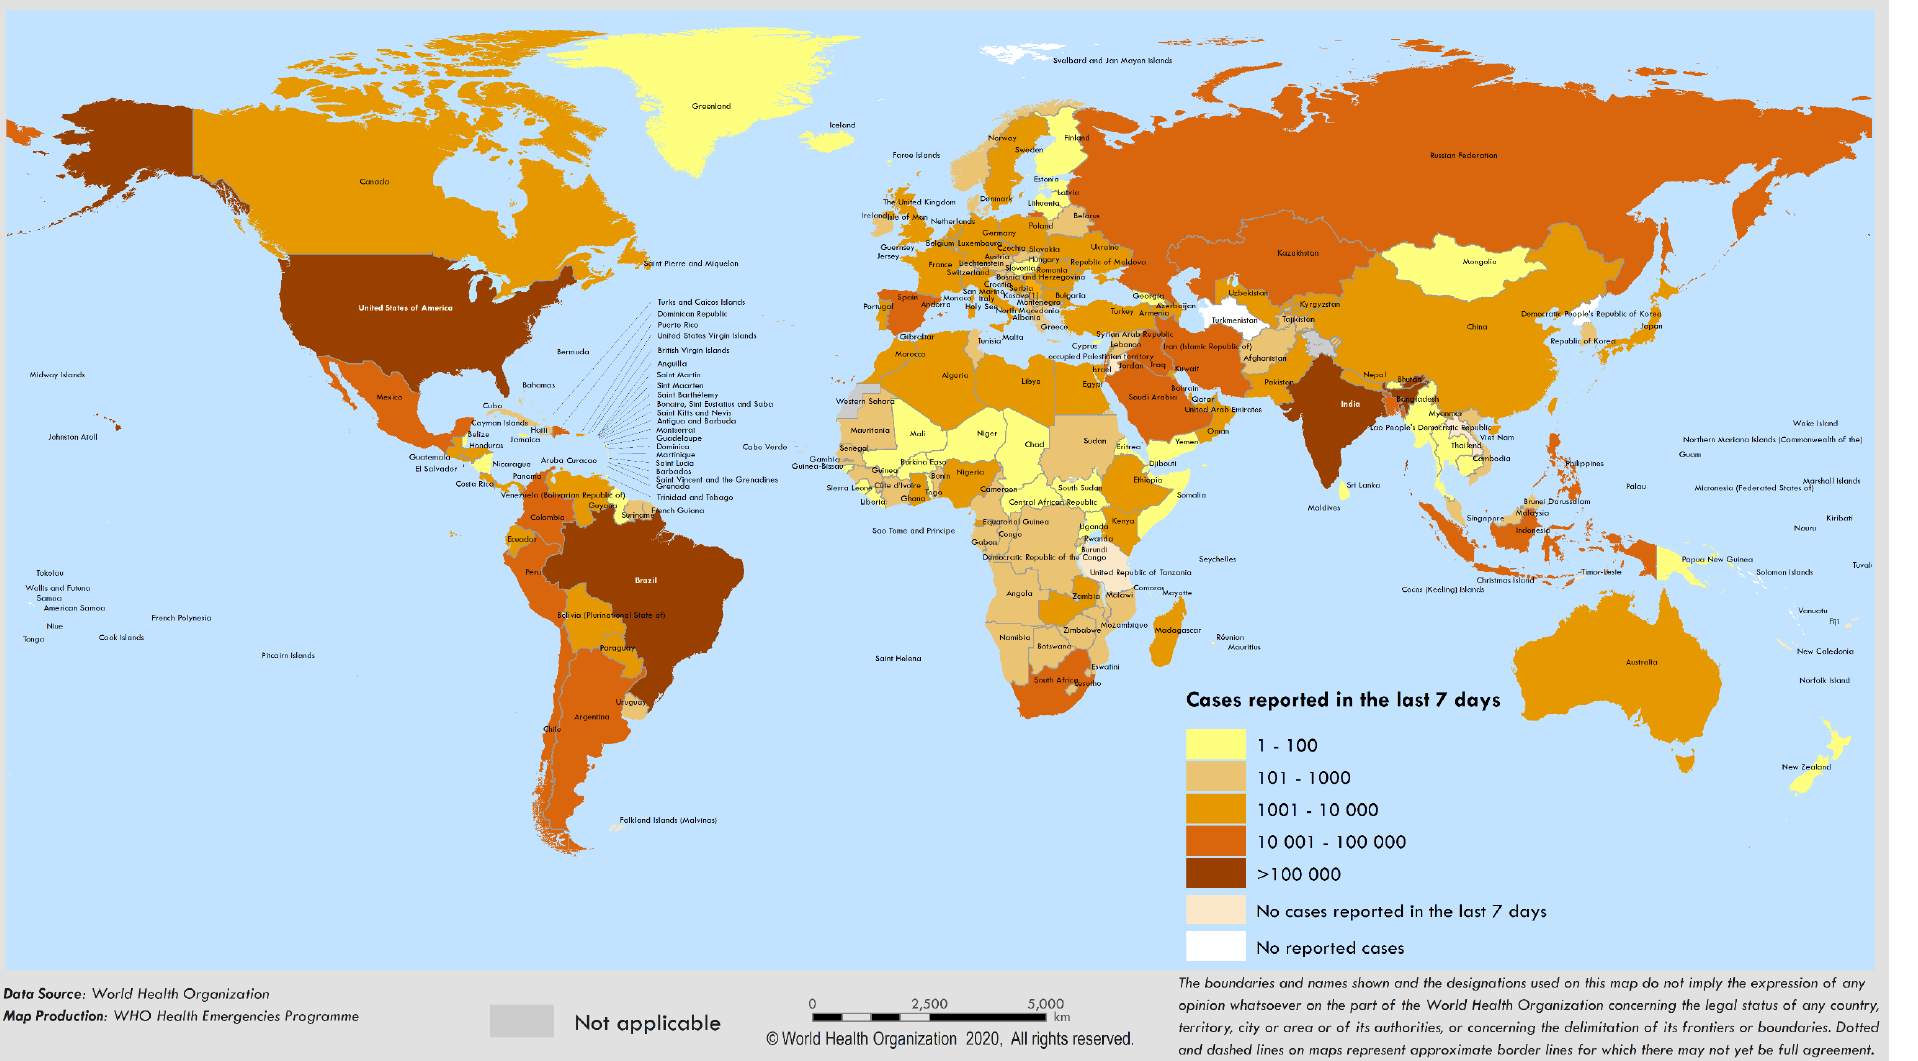
**See Annex 1 for data, table and figure